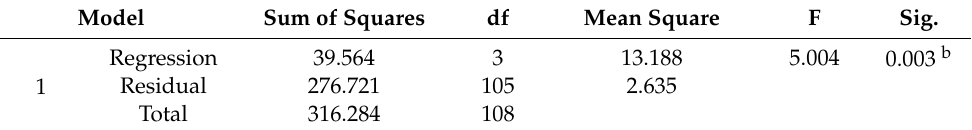
Table 7. Multiple regression results for HEP adherence a . Model